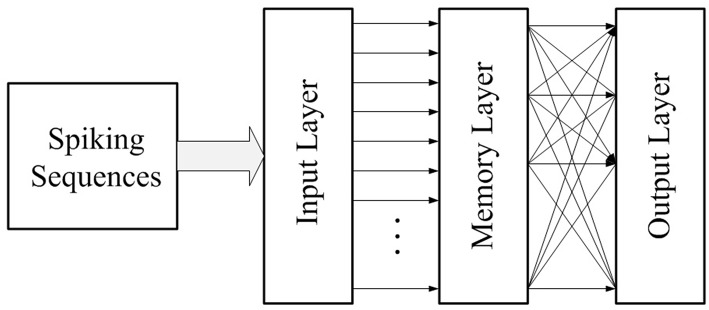
Structure of our memory neural network.